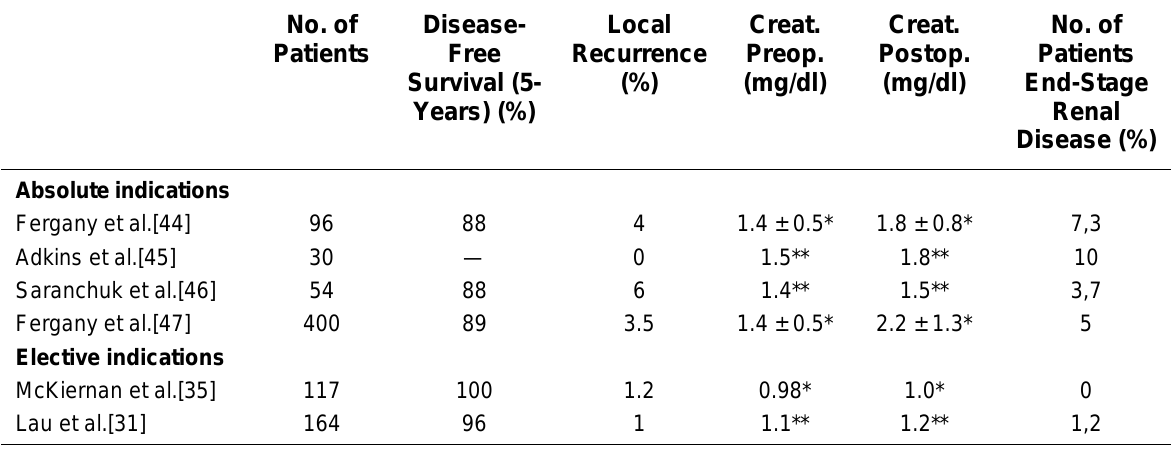
Recent Studies on the Oncological Outcome and Analysis of Renal Function after NSS No.